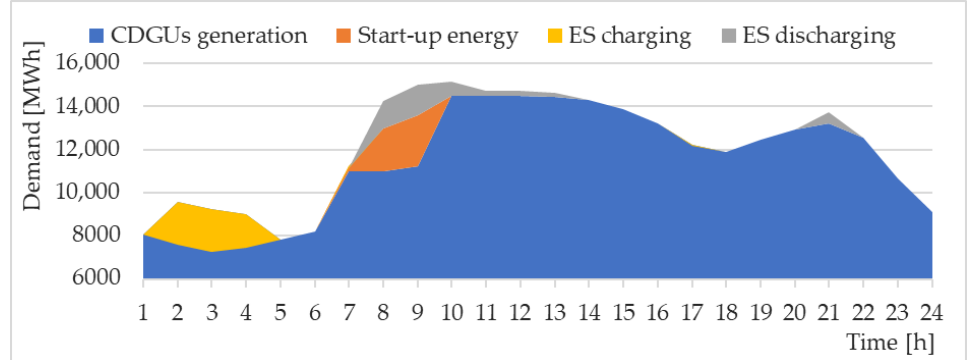
Figure 11. Results of the additional simulation—operation of the modeled system assuming lower costs of energy storage (ES).